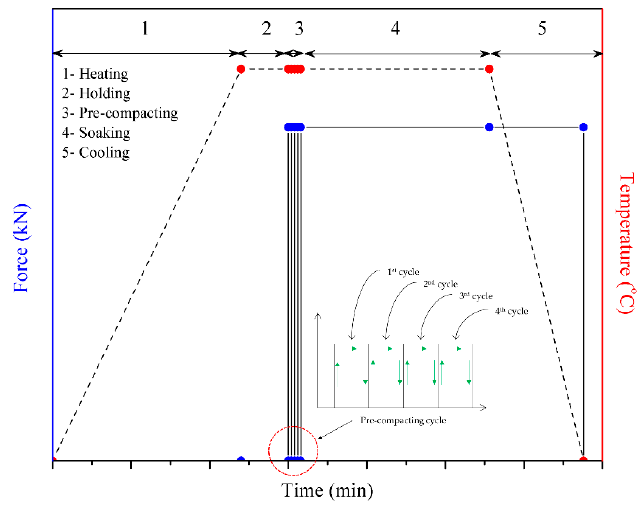
Figure 4. Hot press forging operation flow.